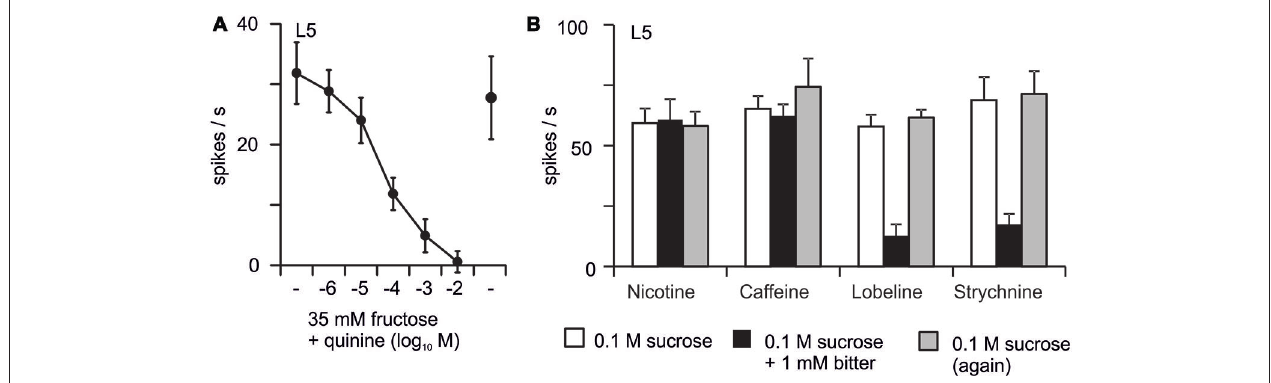
FIGURE 4 | Inhibition of the response to sugars by bitter chemicals (Sellier, 2010). (A) Adding increasing concentrations of quinine to 35 mM fructose inhibits the firing activity recorded from L-type sensilla of the proboscis of Drosophila . (B) At the same molar concentration (1 mM), bitter chemicals differ in their power to inhibit the response to 0.1 M sucrose. Each point represents the average of 5–10 responses. Bars display